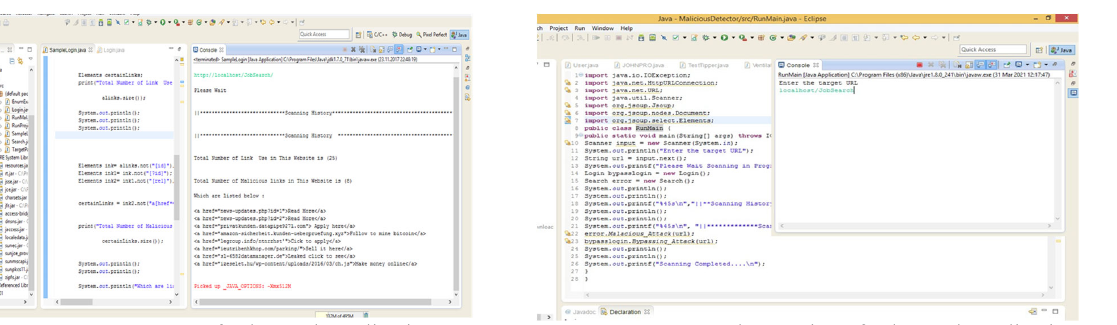
Fig. 8. Input URL of JobSearch application Fig. 9. Output result scanning of JobSearch